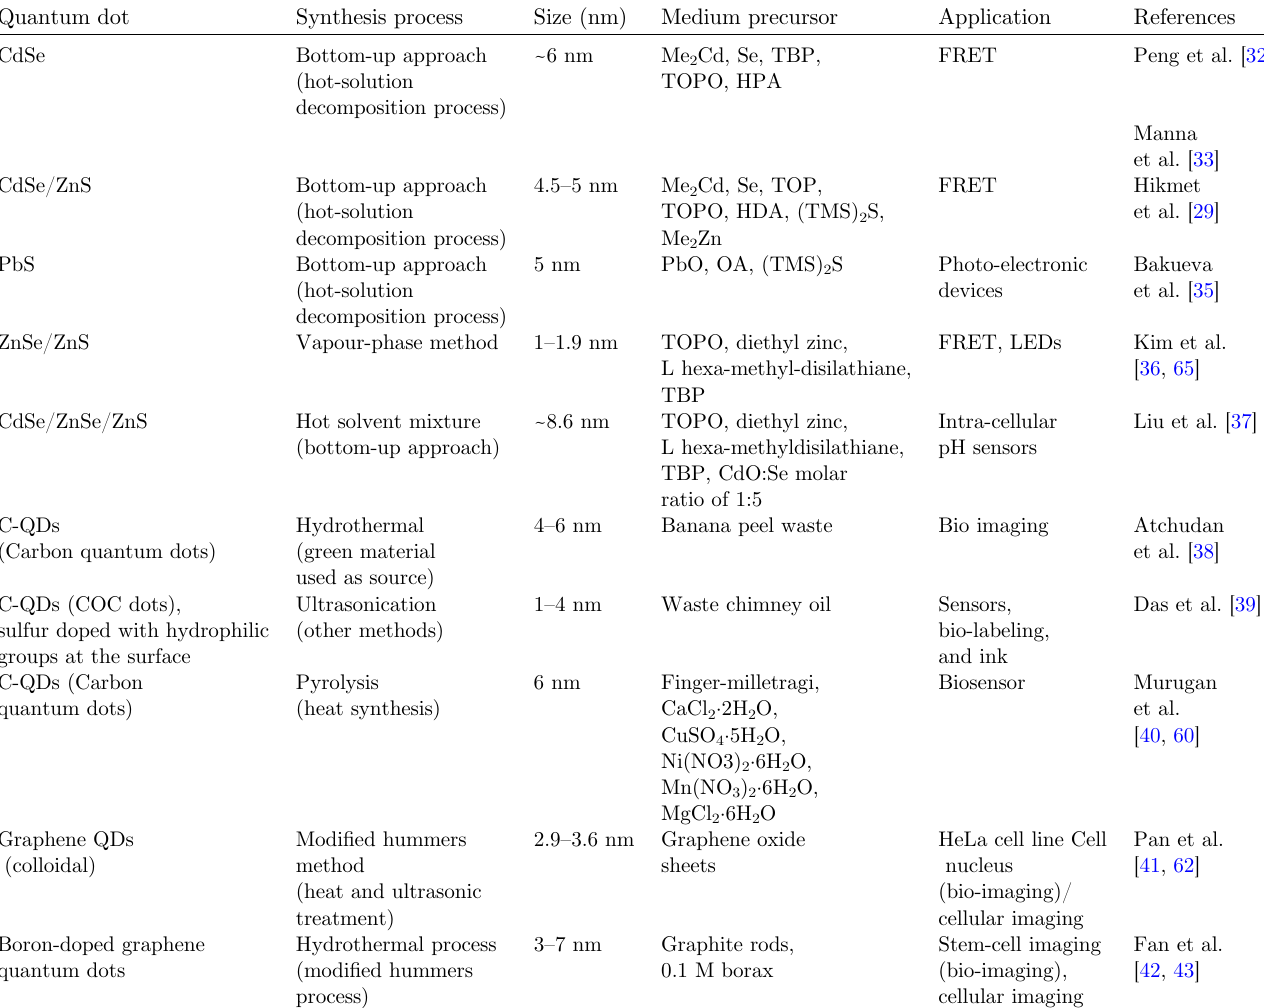
Table 1. Examples of synthesized quantum dots with their precursors, sizes and their respective synthesis